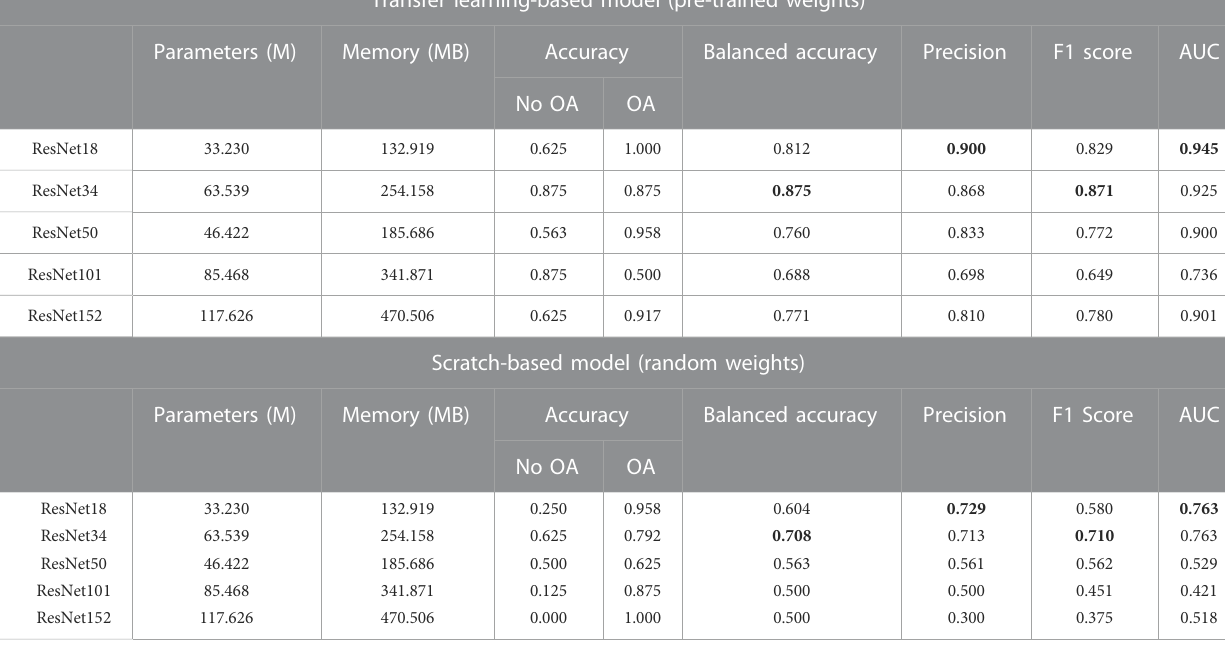
TABLE 2 Performance comparison of ResNet variants.